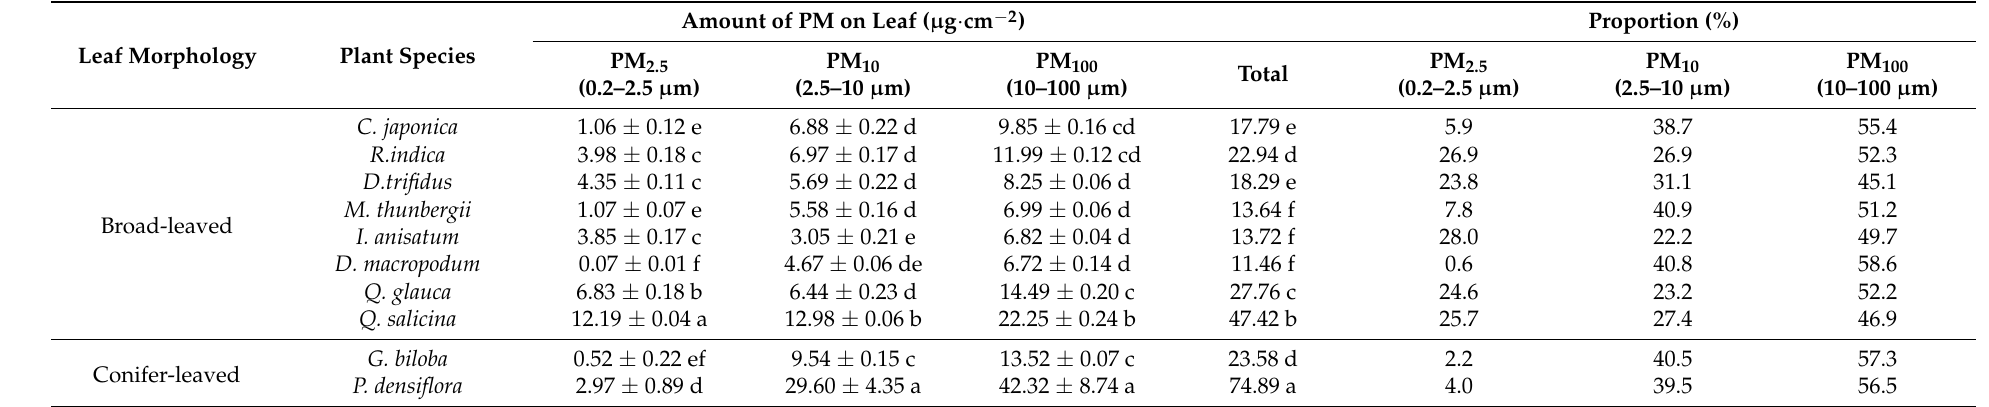
Table 3. Total amount of particulate matter (PM) accumulated on leaf surface of eight evergreen and two coniferous tree species by PM size. Data are mean ± SD with 5 replicates of 30 leaves each. Species marked with different letters are significantly different by Duncan multiple test ( p < 0.05).